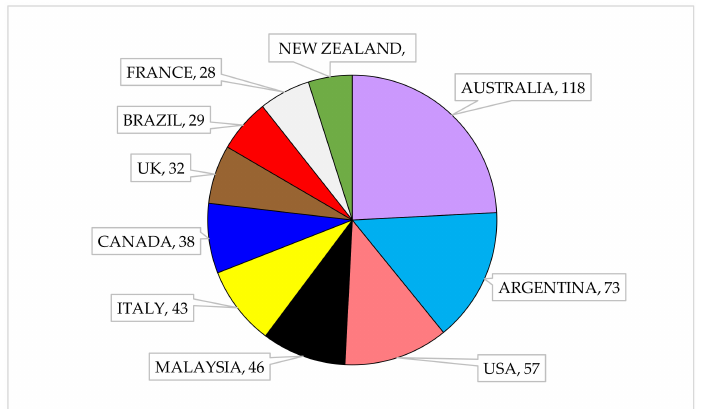
Figure 2. Top ten active countries in publishing Antarctic microbial hydrocarbon remediation related literature.